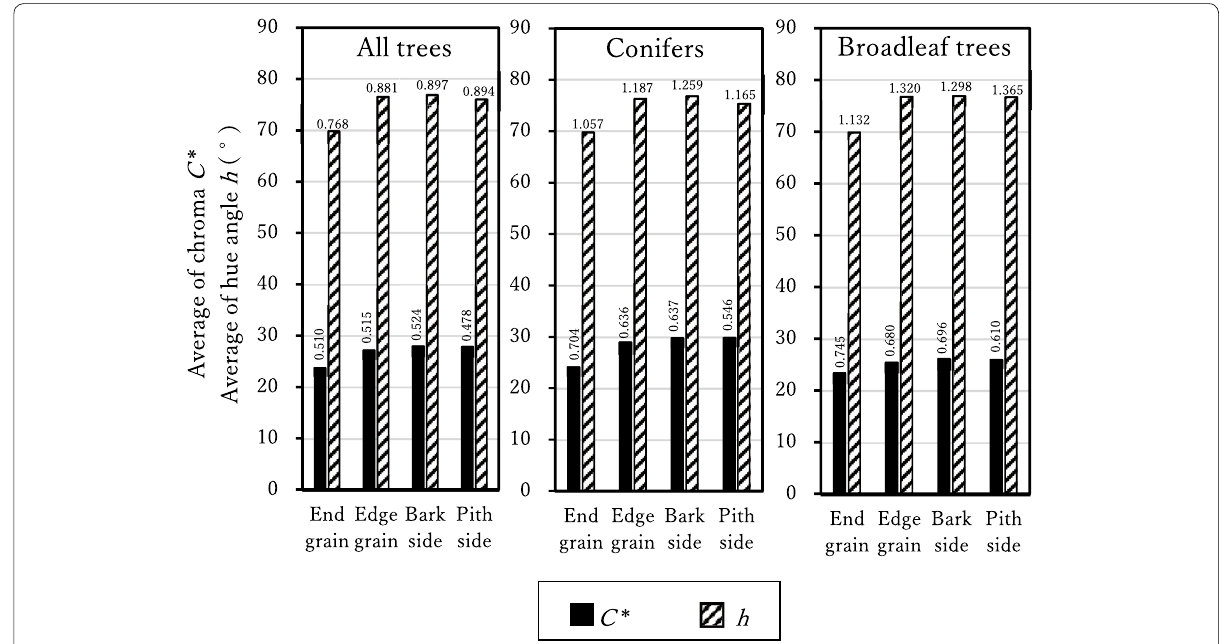
Fig. 6 Calculated Chroma C * and Hue angle h in L * C * h color space. Standard error values are shown near the tip of each